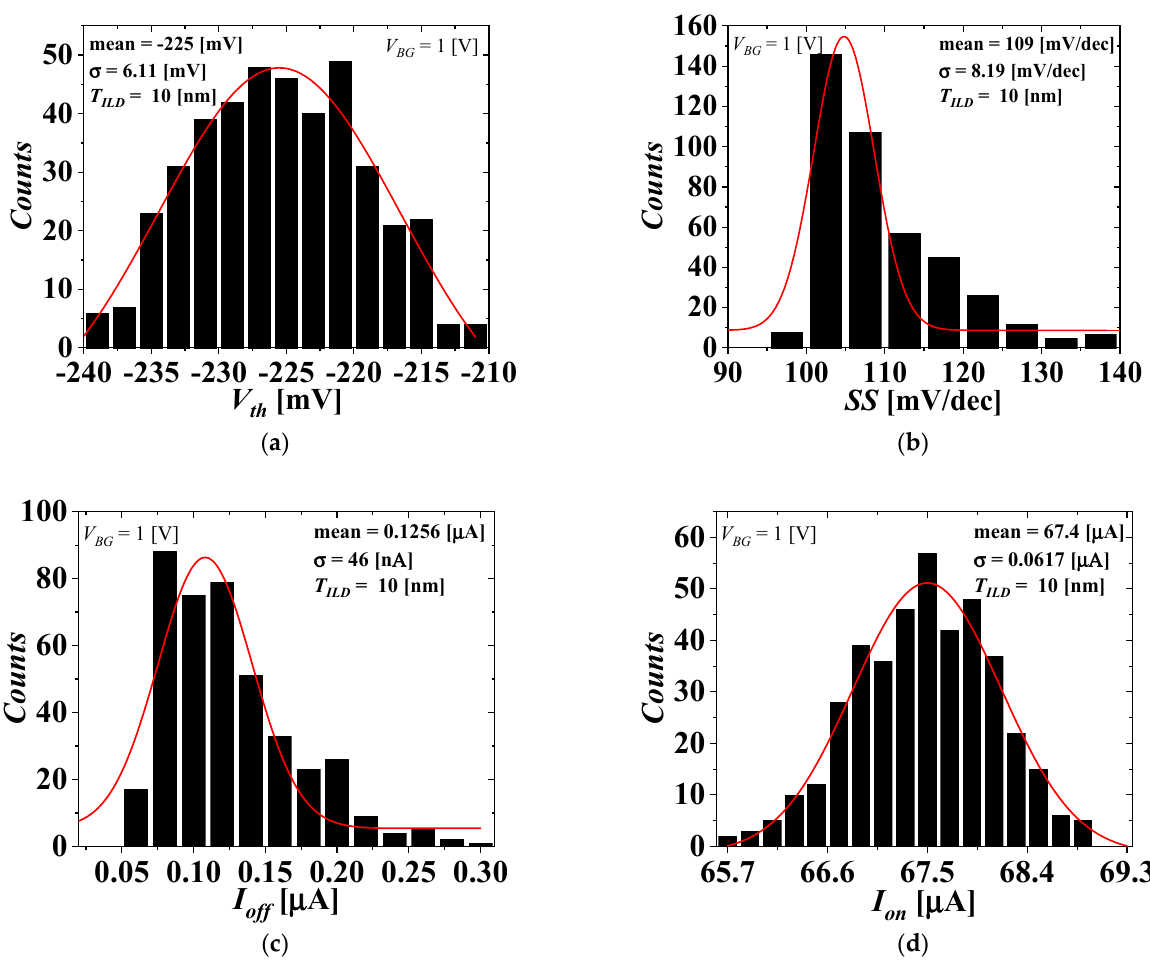
Figure 6. The distributions of the electrical parameters of the top-tier NMOS considering the WFV effects of both the top- and bottom-tier gates when V BG = 1 V. (a) V th , (b) SS, (c) I off , and (d) I on .